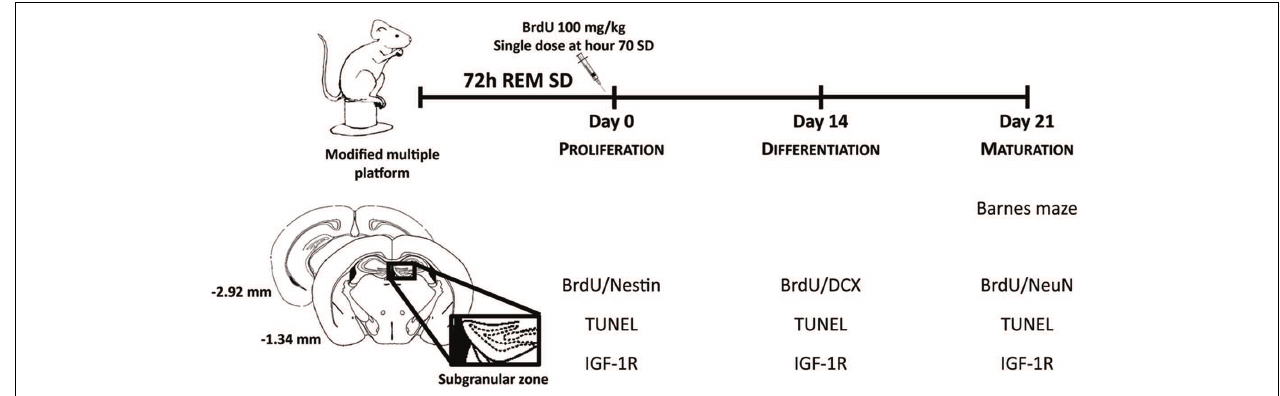
FIGURE 1 | Experimental design. Mice were exposed to REM sleep deprivation for 72-h. Twenty-one days later, we evaluated spatial memory (Barnes maze). Cellular analysis was done at different time points to assess: proliferation, differentiation and maturation of SGZ neural progenitors, as well as apoptosis (TUNEL) and expression levels of